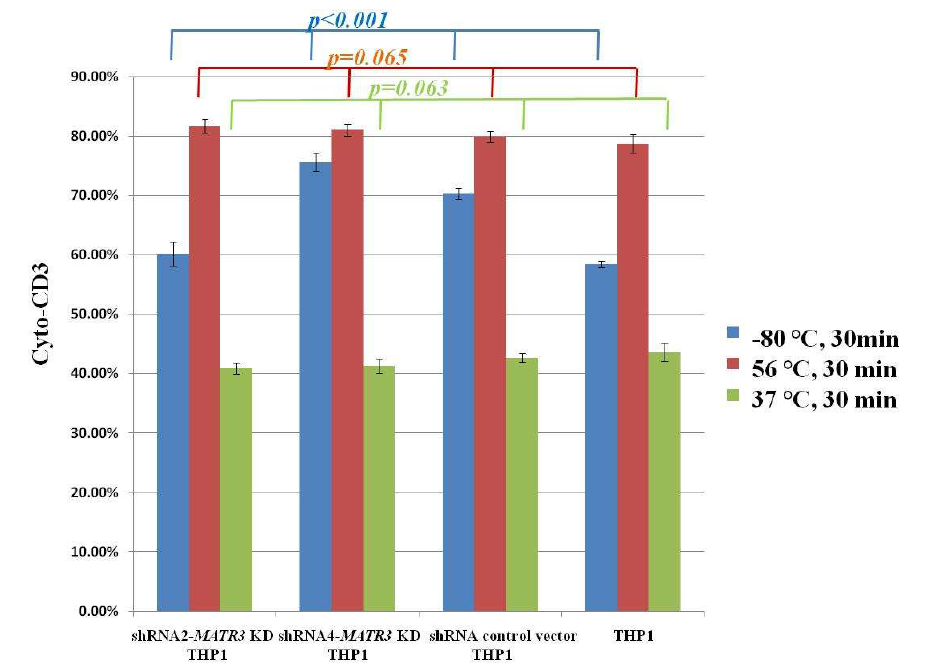
Figure 5. Cytoplasmic CD3 expression in shRNA2- , shRNA4-MATR3 KD THP1, control vector transfected THP1, and naïve THP1 cells. Necrotic Jurkat E6 cells were effectively phagocytosed by MATR3 KD THP1 cells. The y-axis represents the percentage of cytoCD3+CD13(+)/CD13(+) cells.